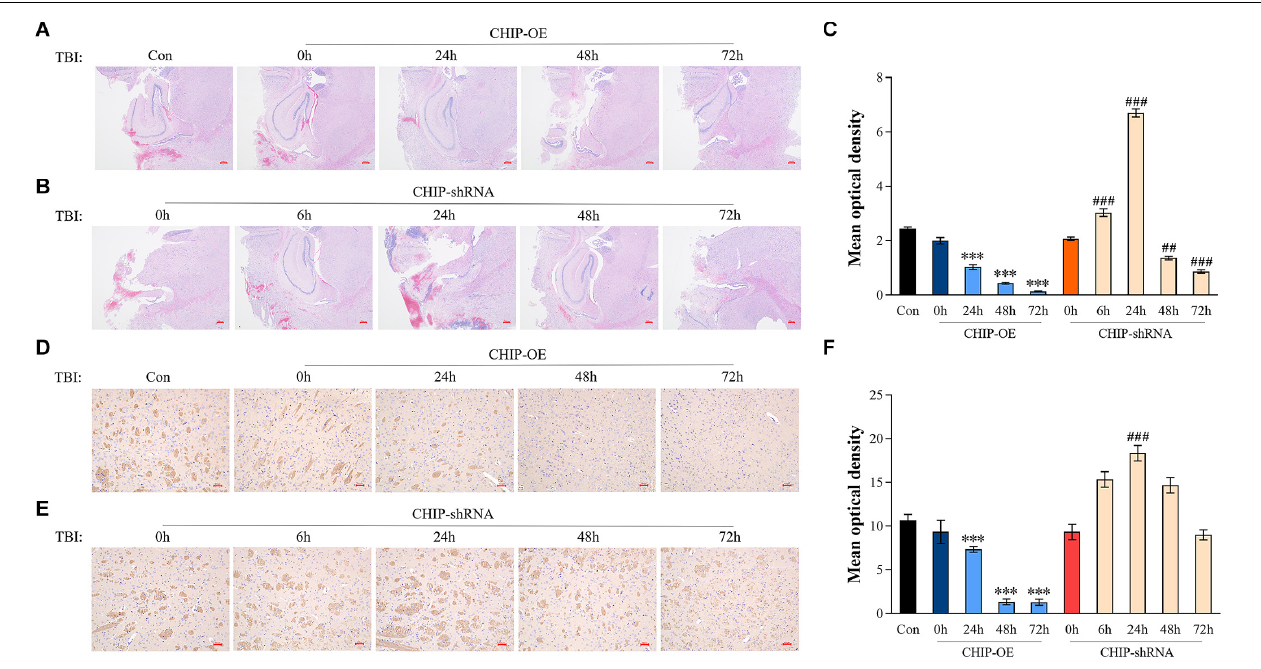
FIGURE 7 | Hematoxylin and eosin (HE) staining and blood–brain barrier permeability evaluation after in vivo traumatic brain injury. (A) HE staining (40 × ) in pericontusional cortex at 0, 24, 48, and 72 h after CCI in CHIP-OE group. (B) HE staining (40 × ) in pericontusional cortex at 0, 6, 24, 48, and 72 h after CCI in CHIP-shRNA group. (C) Semi-quantified analysis of hemorrhagic injury (red stained areas) using mean OD. CHIP-OE 24, 48, and 72 h vs. CHIP-OE-0h, ∗∗∗ p < 0.001; CHIP-shRNA 6, 24, 48, and 72 h vs. CHIP-shRNA-0 h, ## p < 0.01, ### p < 0.001. (D) Immunohistochemical staining (200 × ) of IgG leakage in pericontusional regions at 0, 24, 48, and 72 h after CCI in CHIP-OE group. (E) Immunohistochemical staining (200 × ) of IgG leakage in pericontusional regions at 0, 6, 24, 48, and 72 h after CCI in CHIP-shRNA group. (F) Semi-quantitative analysis of leaked IgG protein using mean OD. CHIP-OE 24, 48, and 72 h vs. CHIP-OE-0h, ∗∗∗ p < 0.001; CHIP-shRNA 6, 24, 48, and 72 h vs. CHIP-shRNA-0 h, ### p < 0.001. Scale bars in (A,B) were 200 µ m and, in (D,E) , were 50 µ